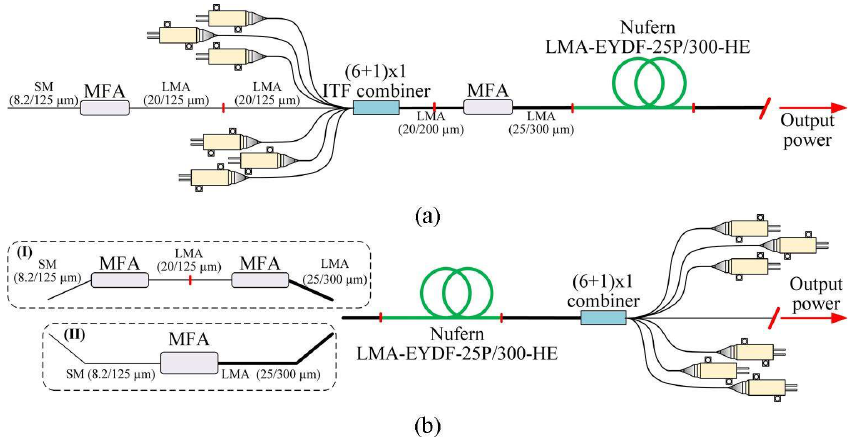
Figure 4. Alterative solution of the third MOPA stage construction: with commercial pump and signal power combiner ( a ) and with a backward-pumping scheme ( b ).